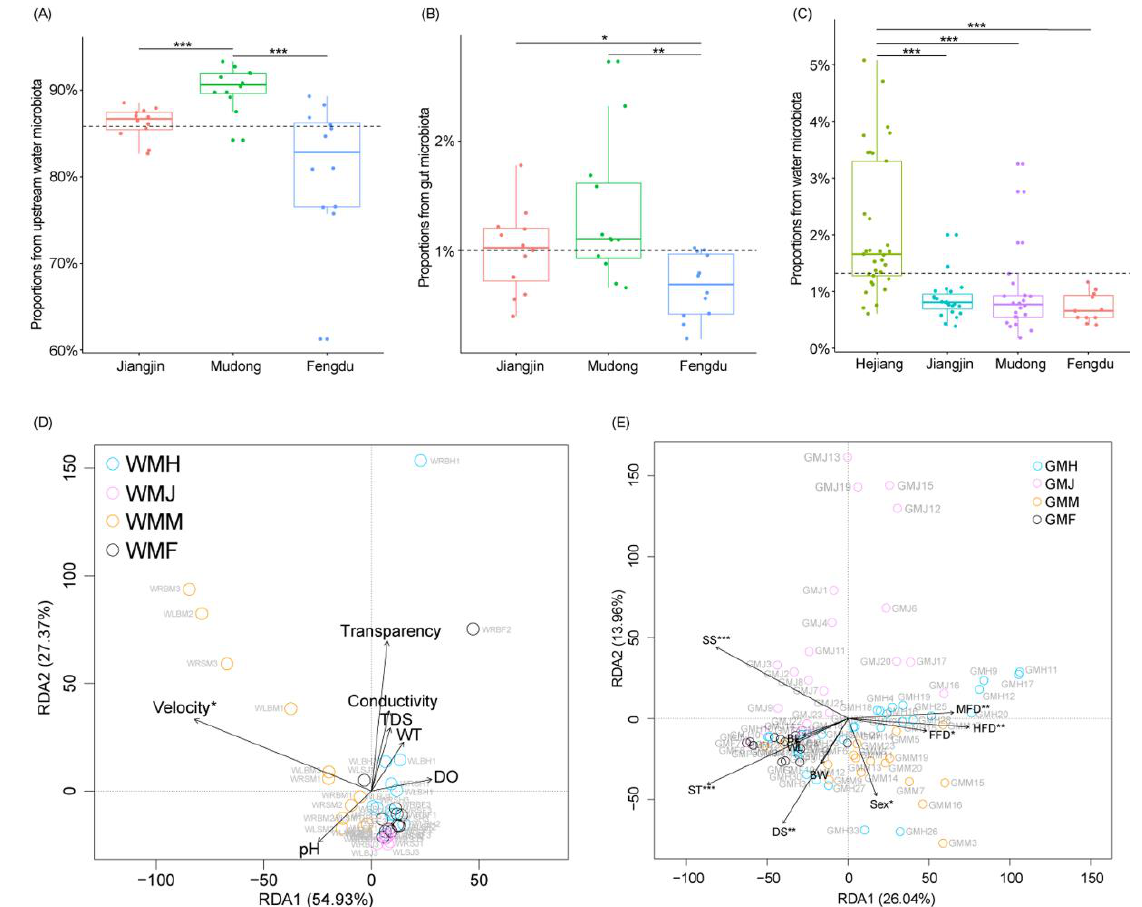
Figure 5. Proportions of bacteria from the upstream water body ( A ) and Rhinogobio cylindricus intestine ( B ) in the downstream water and the proportion of fish intestinal microbiota from the microbiota in the surrounding aquatic environment ( C ). The redundancy analysis profiles show the effect of water physical and chemical indicators on the composition of water microbiota ( D ) and the impact of the R. cylindricus biological index on the intestinal microbiota ( E ). MFD, midgut filling degree; FFD, foregut filling degree; HFD, hindgut filling degree; BW, body weight; DS, developmental stage; ST, sampling time; SS, sampling site; WL, whole length; BL, body length; DO, dissolved oxygen; WT, water temperature; TDS, total dissolved solids. *, p < 0.05; **, p < 0.01; ***, p < 0.001.